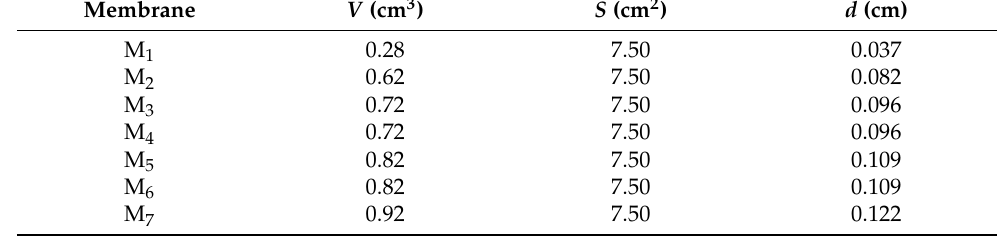
Table 2. Dimensions of the membranes. V , S , and D are the volume, surface, and thickness, respectively. Membrane